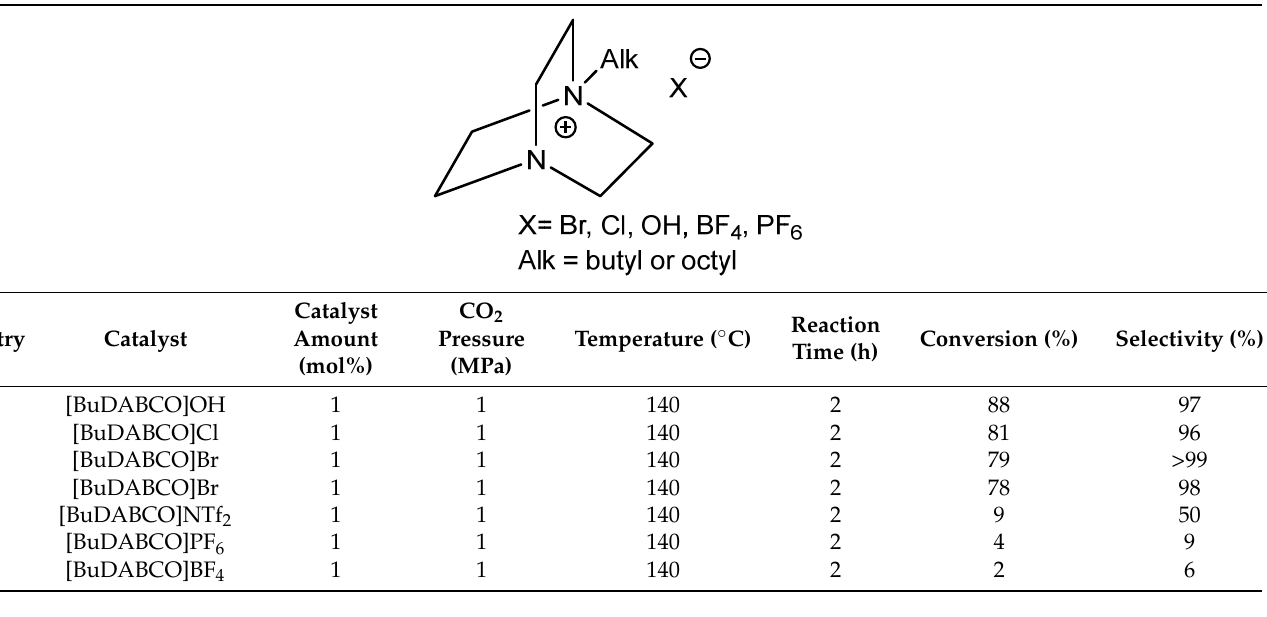
Table 13. Cycloaddition of CO 2 to epoxides catalyzed by 1,3-di-tert-butylimidazolium-2-carboxylate [65].